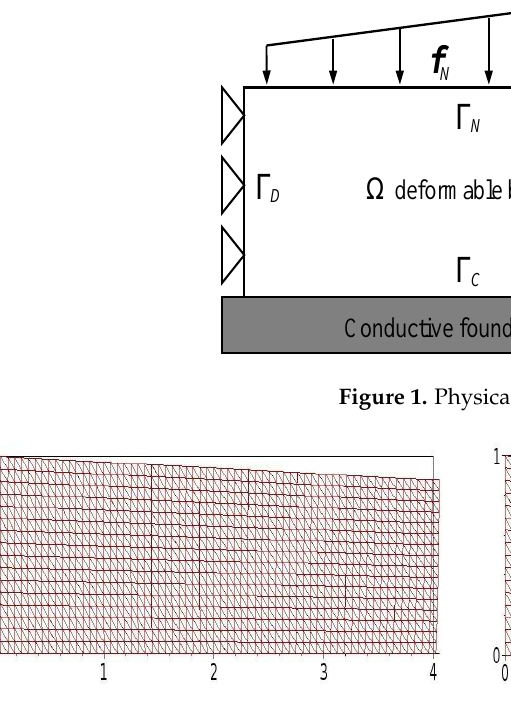
Figure 2. Amplified deformed mesh in the case of an insulated foundation (left) and in the case of a conductive foundation (right).